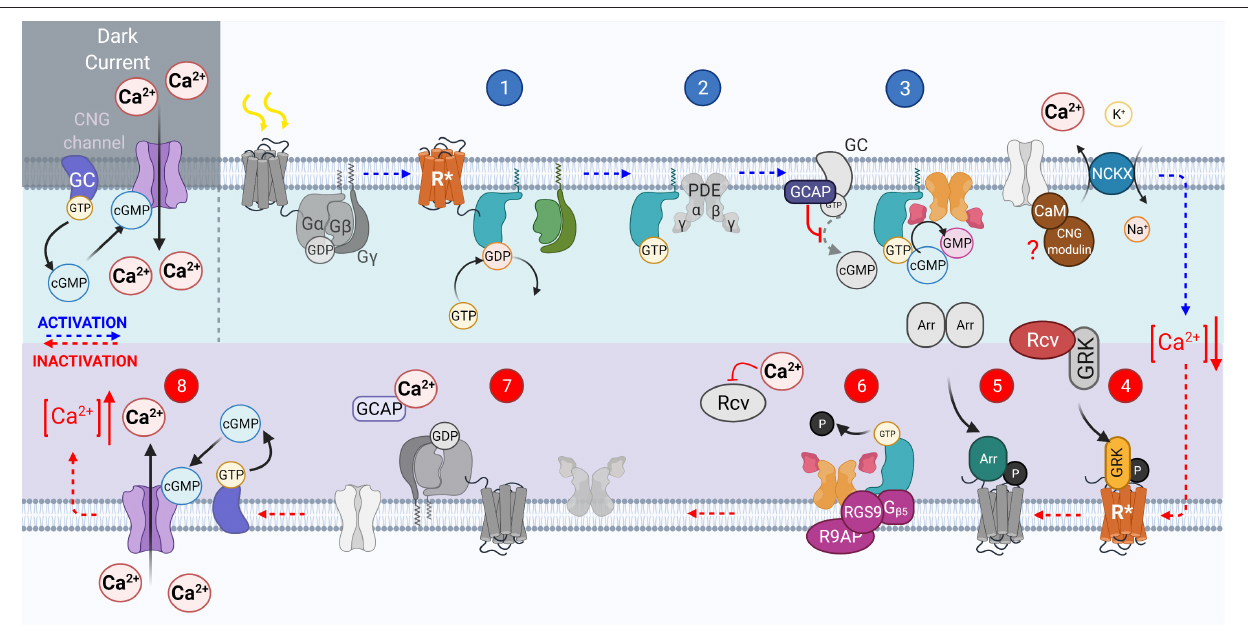
FIGURE 2 | The vertebrate phototransduction cascade, inactivation, and adaptation mechanisms. The key steps within the vertebrate phototransduction cascade (blue numbering from top left to right) and its subsequent inactivation (red numbering from bottom right to left). In the dark, the CNG channel maintains a dark current, in which Ca 2 + ions influx through open CNG channels as the Guanyl Cyclase enzyme is constituently active. Upon absorption of a photon, the chromophore 11- cis -retinal is isomerized to all- trans -retinal, causing the receptor to become activated (R*). In turn, the associated G protein, transducin, is activated with the exchange of GDP for GTP, G T α * (step 1). G T α * then displaces PDE βγ subunits (step 2). The displaced PDE γ subunit allows cGMP to be reduced to GMP, reducing the concentration of cGMP, closing CNG channels, causing a hyperpolarization of the photoreceptor (step 3). The activated receptor, R*, is inactivated by GRK mediated phosphorylation (step 4). Followed by Arrestin binding (step 5). The GAP protein complex formed of RGS9, R9AP, and G β 5 bound to both PDE γ and activated G T α * causes hydrolysis of GTP on the G T α to GDP (step 6). G T α then dissociates from PDE, reassociating to the βγ subunits, and PDE γ also inhibits the PDE αβ to prevent cGMP hydrolysis (step 7). Intracellular Ca 2 + concentration is raised as CNG channels reopen in response to the increasing cGMP concentration, reestablishing the dark current (step